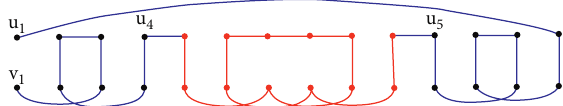
to u in GP ( 8 , 2 ) . 1 1